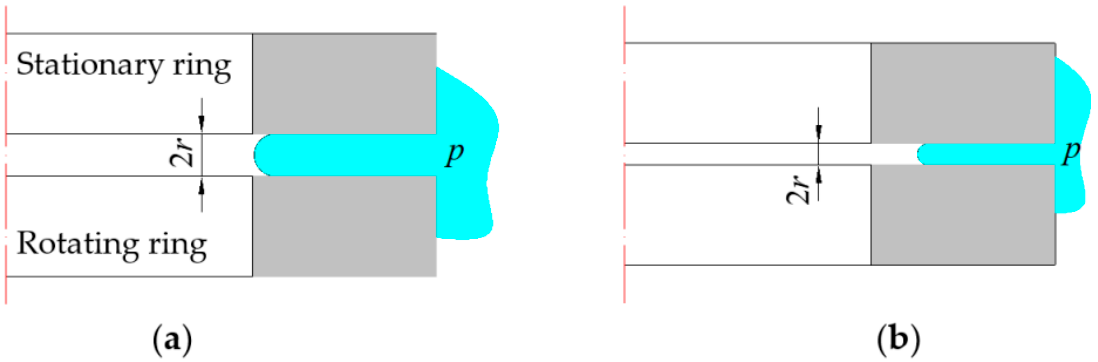
Figure 2. Schematic diagram of the rotating and stationary ring sealing interface. ( a ) Large diameter microchannel; ( b ) Small diameter